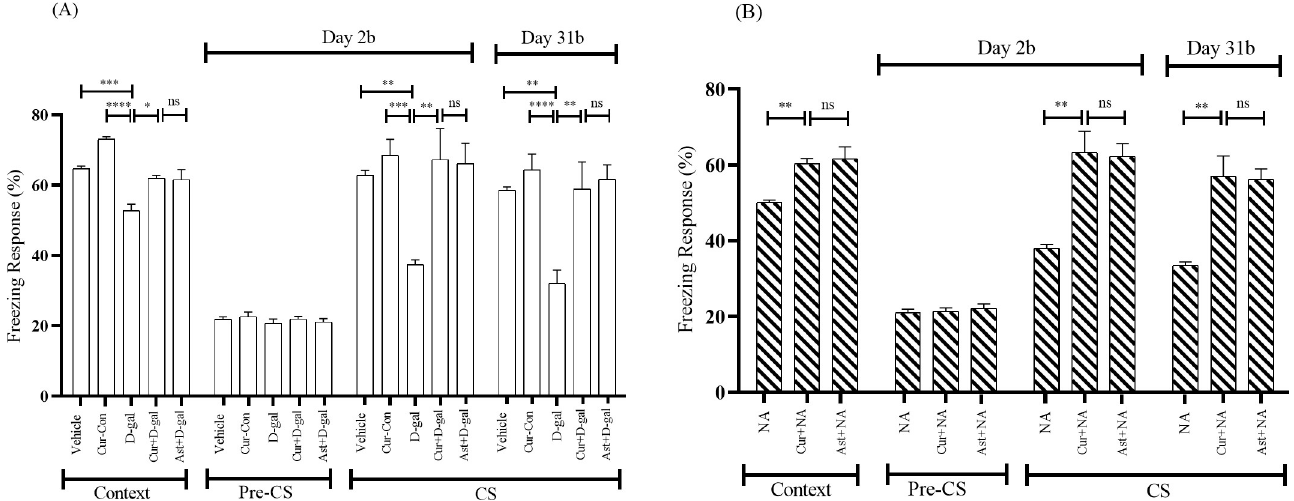
Fig 4. Effect of curcumin on the context and cued fear memory (Day 2b and 31b) of (A) D-gal and (B) NA mice group. The memory was assessed by analyzing the FR. The FR was expressed in percentage (%). Data was presented as mean ± SEM, n = 8 each group; � p < 0.05, �� p < 0.01, ��� p < 0.001, ���� p < 0.0001, ns = not